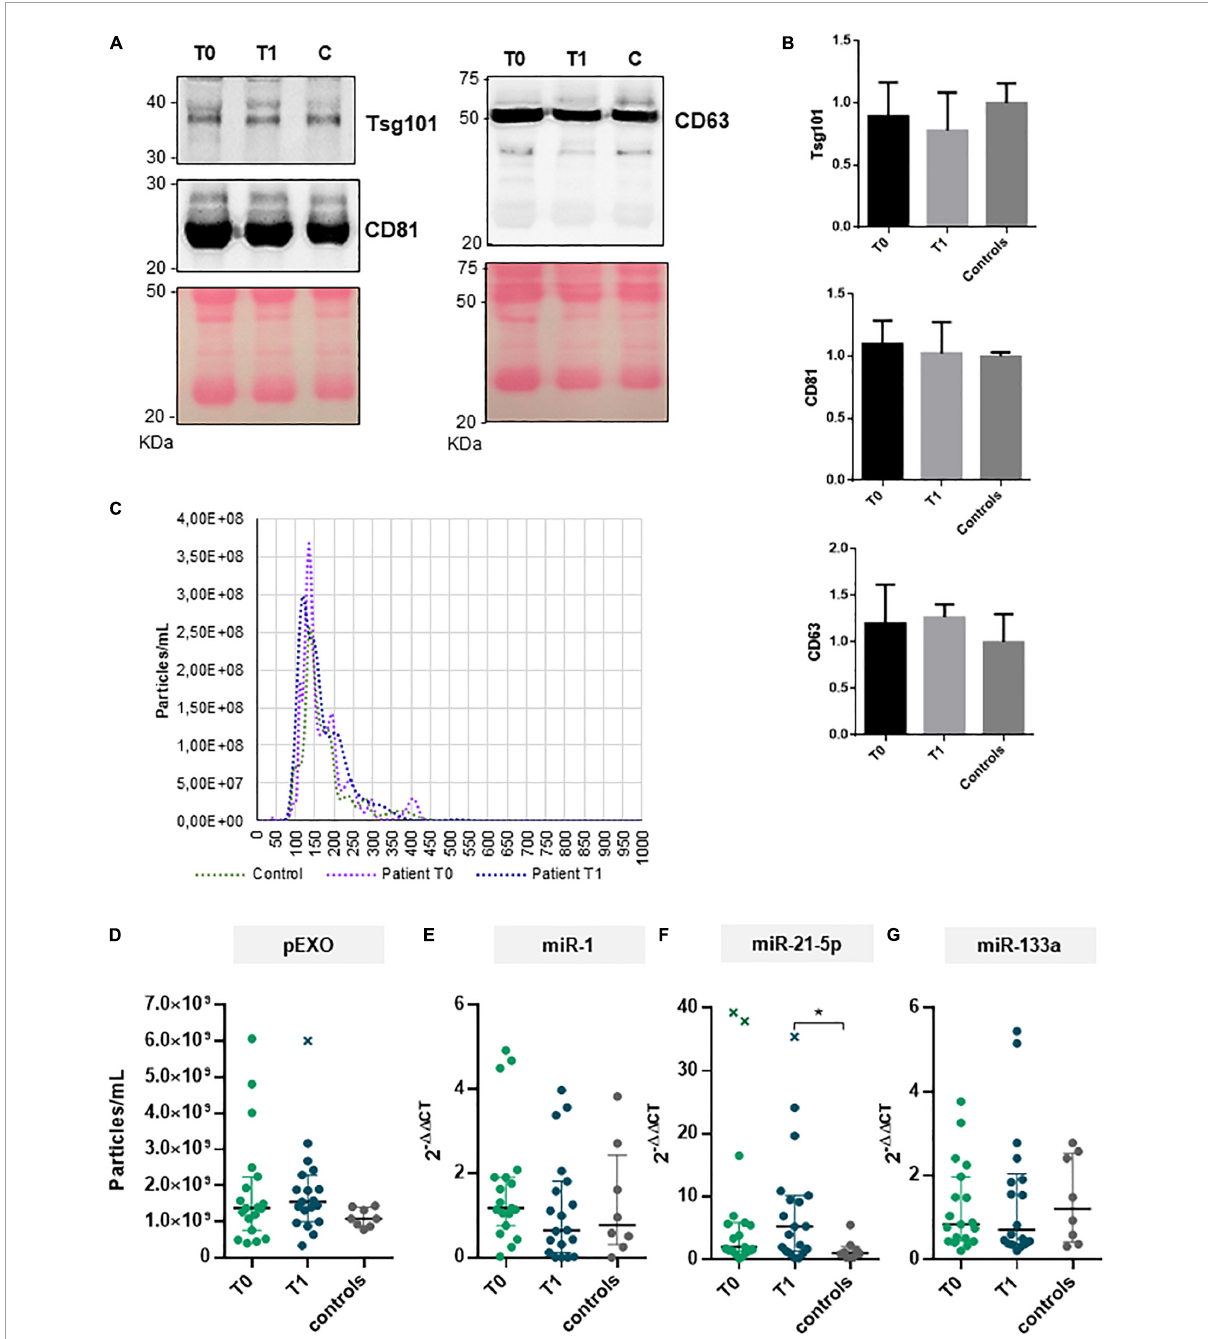
FIGURE3 pEXOs and exosomal miRNAs in primary MR patients subjected to MVR surgery. The pEXOs were isolated from plasma of MR patients ( n = 19) collected before (T0) and 6 months after MVR surgery (T1); pEXOs isolated from healthy controls ( n = 8) were used as control. (A,B) The exosomal markers TSG101, CD81, and CD3 were assessed on the isolated particles by Western blot as described in the methods. (A) One representative experiment is shown. (B) Densitometric analysis of each protein target normalized for the corresponding experiment’s Ponceau staining shows no difference in marker expression among extracts ( N = 3 patients/group). (C) Isolated pEXOs were analyzed by NTA as described in the methods; representative size distribution curves are shown. (D) The pEXOs concentrations were inferred by the NTA’s size distribution curve and shown as particles/ml of starting plasma. (E–G) Exosomal miRNA-1 (E) , miRNA-21-5p (F) and miRNA-133a (G) were assessed by qRT-PCR as described in the methods. Individual data, median value and interquartile range are shown in the graphs. Statistical significance of the differences between matching T0 and T1 data was evaluated by paired Student’s t -test or the Wilcoxon test depending on data distribution. Statistical differences between patients and controls were evaluated by one-way ANOVA (with or without Brown–Forsythe modification for heteroscedastic groups) or the Kruskal–Wallis test, depending on sample distribution; * p <